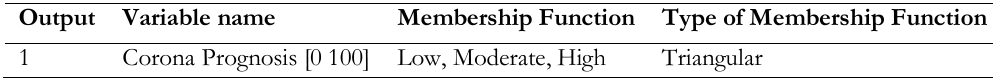
Table 2. Output variable and its membership function.